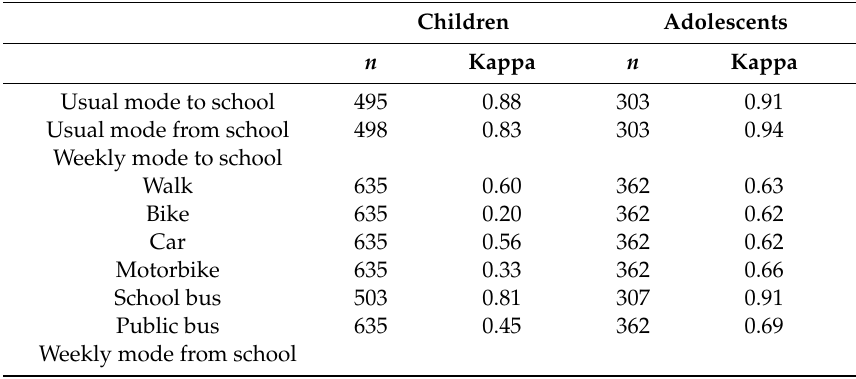
Table 3. Test-retest reliability of the “New Version of Mode and Frequency of Commuting To and From School” questionnaire in children and